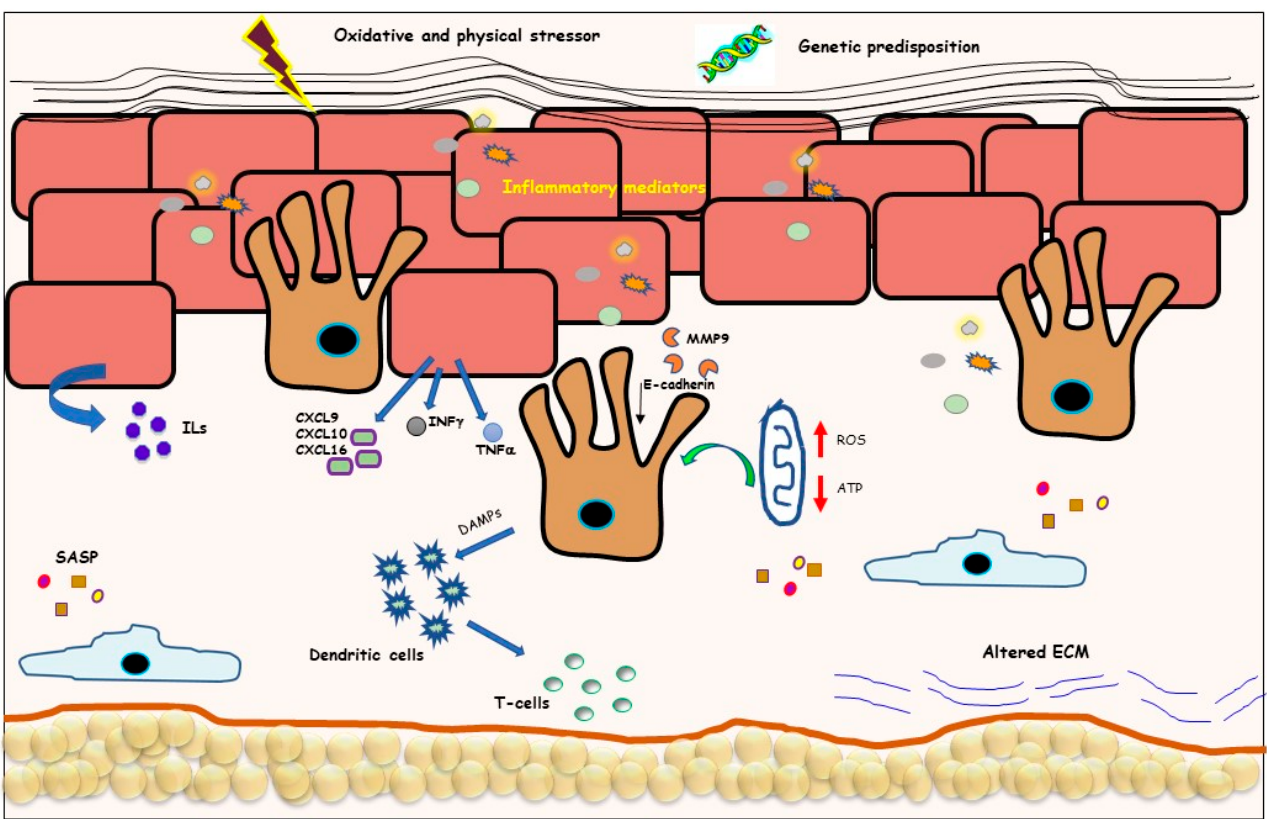
Figure 1. Combined factors concurred with vitiligo pathogenesis. Graphic representation of the different alterations of vitiligo skin. Normal-appearing vitiligo skin is characterized by a thicker epidermis and a progressive loss of functional melanocyte rate. Oxidative stress in keratinocytes leads to the production of several inflammatory mediators. Intrinsic metabolic defects increase reactive oxygen species (ROS) production and decrease ATP content involving dermal and epidermal cells. In addition, vitiligo cells present reduced antioxidant ability and release senescence- associated proteins.